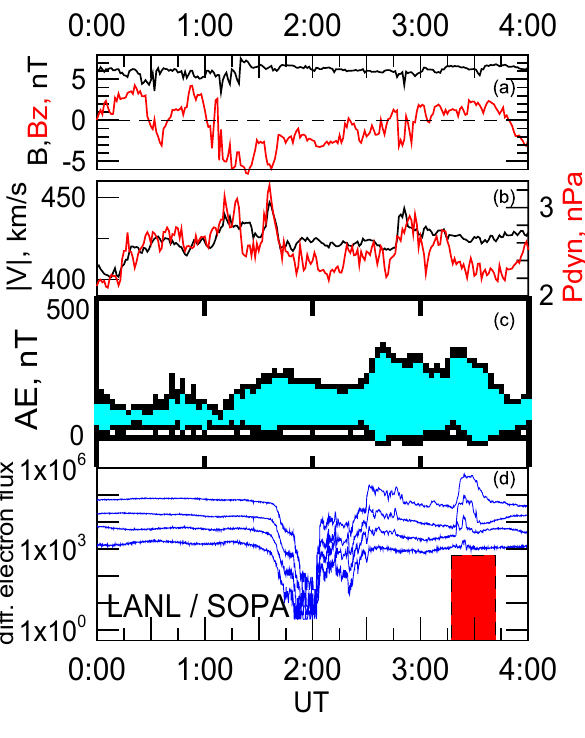
Fig. 2. ACE observations in the solar wind: magnetic field – (a) , velocity and pressure – (b) (shifted to X=10 R E ). Preliminary AE index (c) and energetic electron fluxes at L095 (d) are also shown. The period of interest is marked by a red